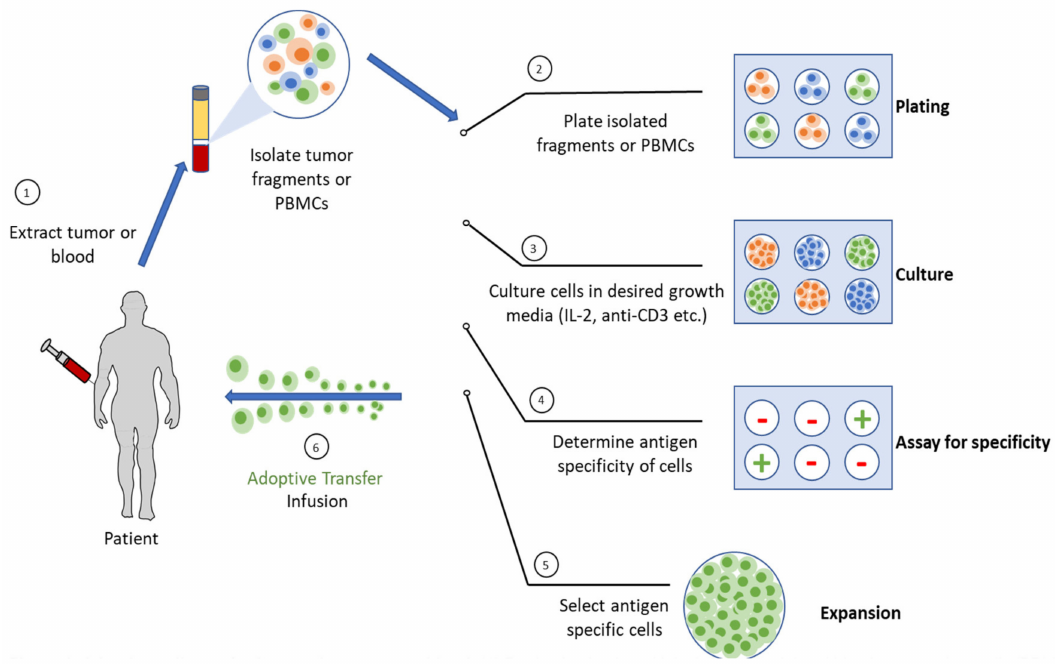
Figure 1. Adoptive cell transfer from patient tumor or blood. (1) Production begins with isolation of peripheral blood mononuclear cells (PBMC) from leukapheresis or tumor is excised and multiple individual cultures are isolated and (2) plated separately followed by (3) selection and activation of T cells. (4) T cells then undergo genetic modification for generating CAR-T cells or tumor cultures are assayed for specific tumor recognition. (5) Cells are expanded in presence of interleukins and when desired dose cell numbers are achieved, expanded cells are harvested and dose is formulated. (6) QC tests are performed to ensure that drug meets release criteria and is then fused into patients with or without conditioning lymphodepleting chemotherapy